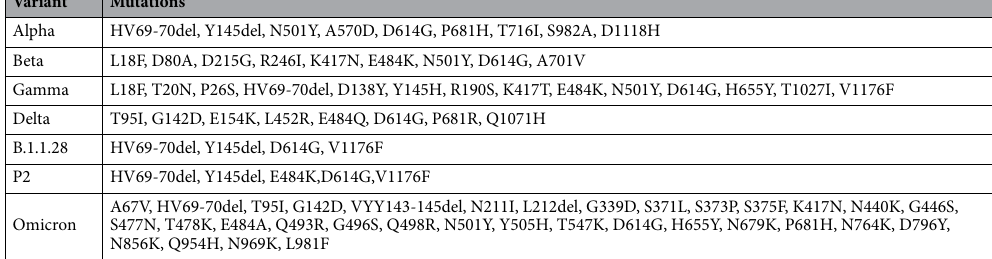
Table 2. Mutations the Spike protein of the SARS-CoV-2 variants from 39